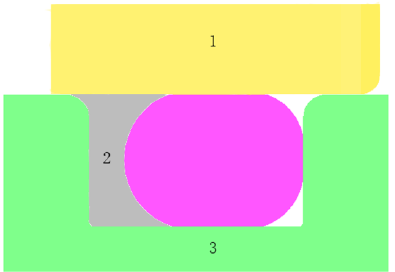
Figure 5. Modeling of working mode. The pressure of hydraulic fluid, which is represented with number 2, is applied to the deformed surface of the rubber ring by pre-compression function. And the piston rod numbered 1 and the groove numbered 3 are applied with fixed